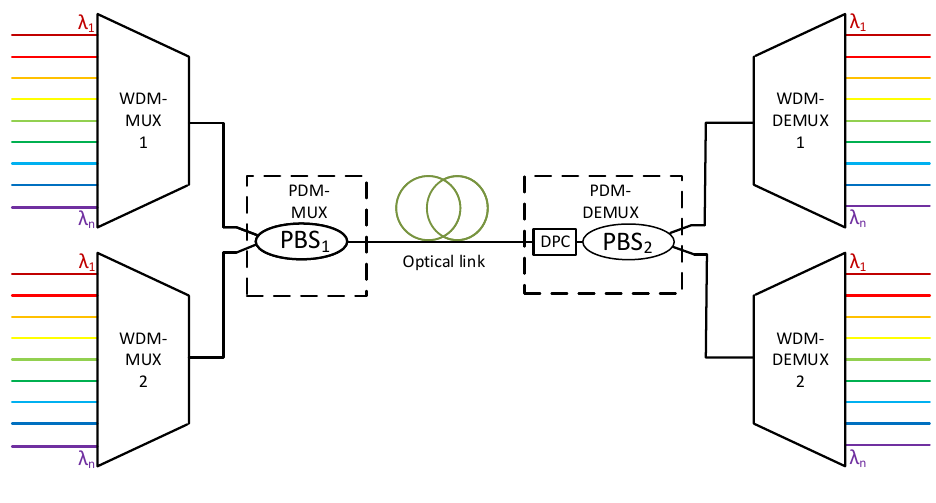
Figure 8. Block scheme of